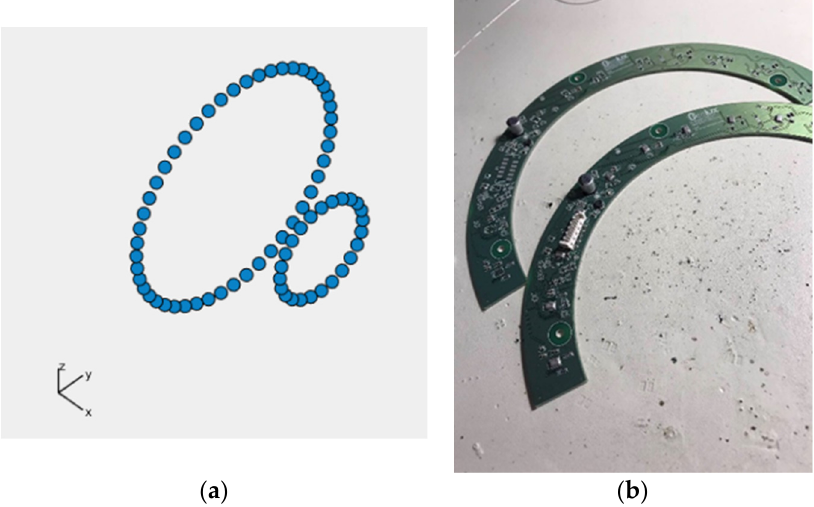
Figure 4. ( a ) Positions of microphone array circles on the prototype of a hemisphere-shaped acoustic camera in coordinate system, x being the broadside direction ( Acoustic Camera 1 ); ( b ) Printed circuit board with mounted electronic components for the prototype of a hemisphere-shaped acoustic camera ( Acoustic Camera 1 ).